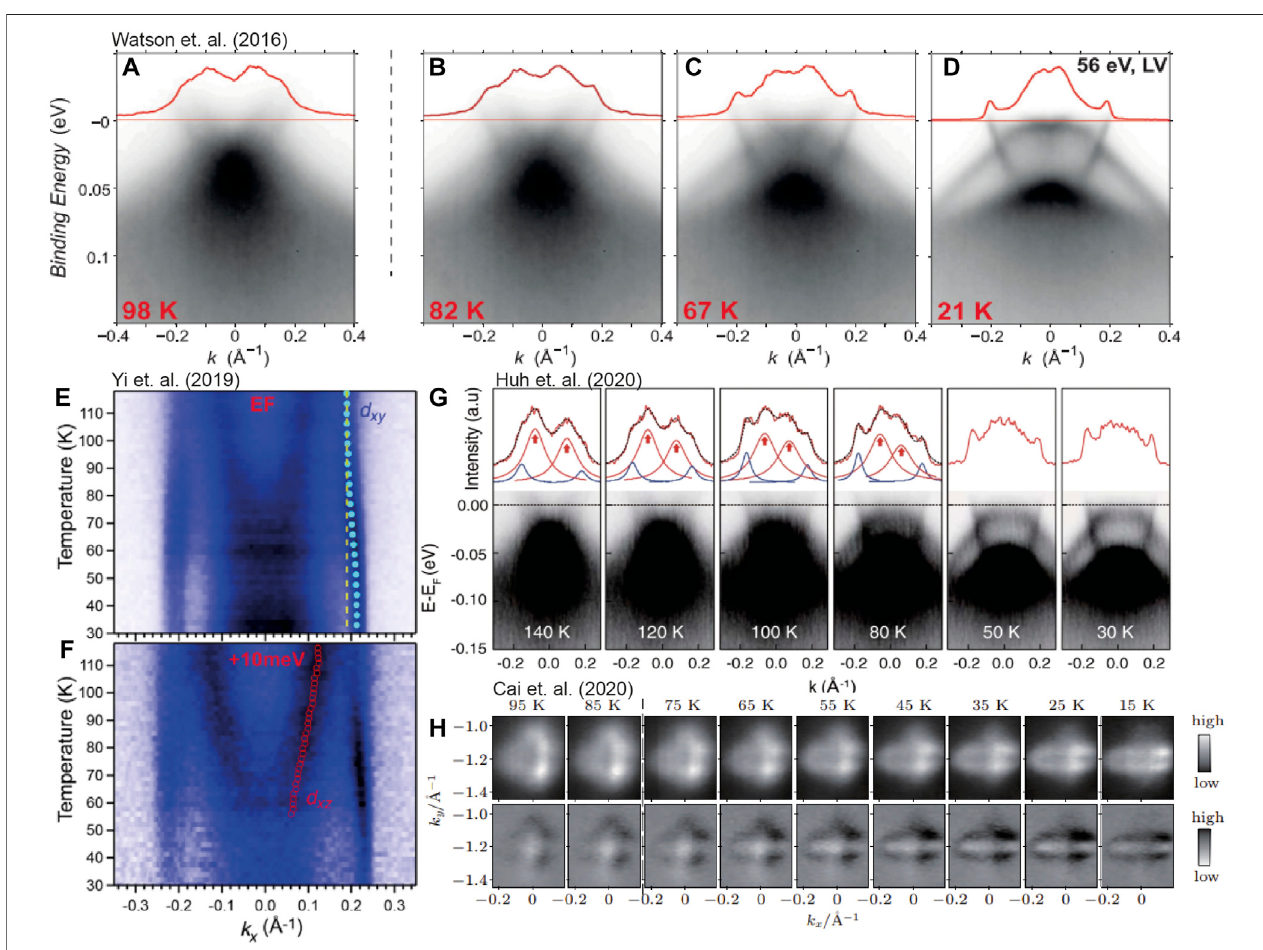
FIGURE 4 | Summary of the temperature dependent ARPES measurements of the electron pocket of FeSe (A – D) measurements from twinned crystals of the electron bands near the A point ( h ] = 56 eV), as a function of temperature, taken from Watson et. al. [32]. (E,F) Spectral intensity at the Fermi energy (E) and 10 meV above the Fermi energy (F) , asa function oftemperature on a detwinned crystal of FeSe, taken from Yi et. al. [35]. (G) Temperature dependence ofthe bands near the A point ( h ] = 56 eV) for a detwinned crystal of FeSe, taken from Huh et. al. [36]. (H) Fermi surface maps as a function of temperature on detwinned crystals of 9% SulphurdopedFeSe,takenfrom Cai et.al. [38]. (E,F) reproducedfromRef.[35]under theCreative Commons Attribution 4.0International License. (G) reproduced from Ref. [36] under the Creative Commons Attribution 4.0 International License. (H) Reproduced from Ref. [38] with permission from Chinese Physics